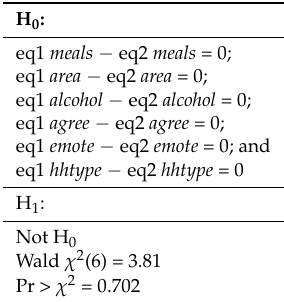
Table 4. Wald test of parallel lines